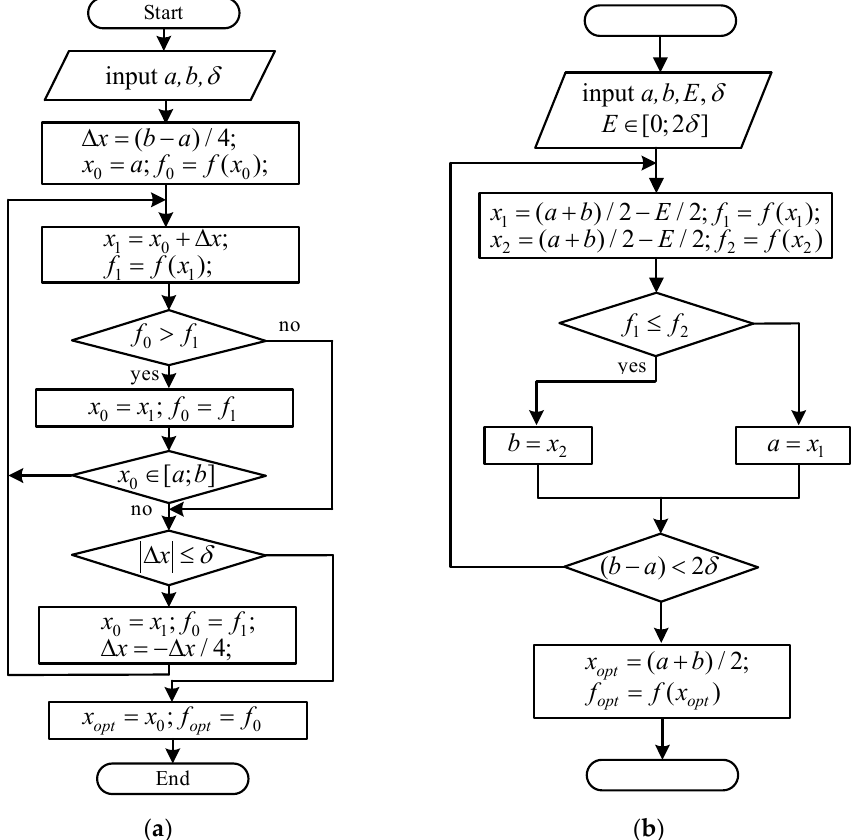
Figure 7. Block diagrams of the FL algorithm for OHPLs based on the following methods: ( a ) bitwise search; ( b ) dichotomies.